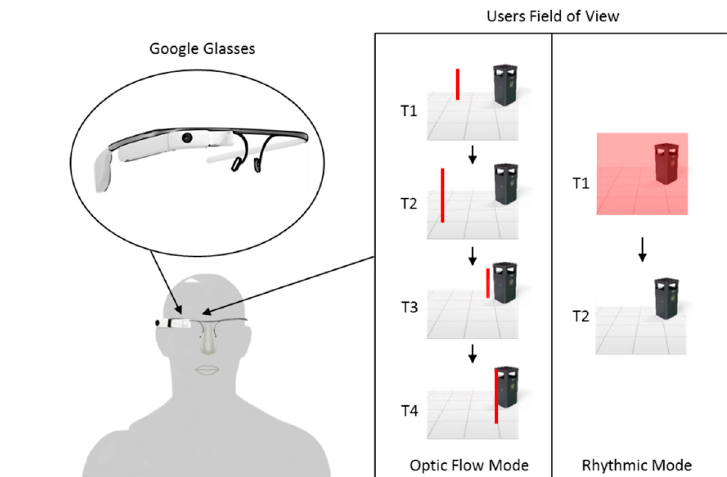
Figure 11. Illustration of user wearing google glass and their field of vision during continuous visual cueing. The Google ‘Glass’ system provides two modes of continuous visual cueing. During optical flow mode, a virtual vertically oriented line continually moves forward on the left and then the right side of the screen at a steady rate (T1–T4). During rhythmic mode, the display flashes on and off a transparent red screen at a set rate (T1–T2).